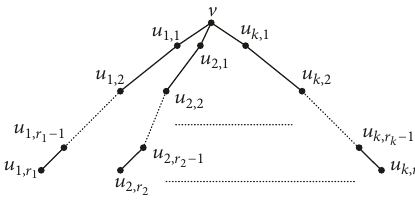
Figure 9: A radioactive tree.